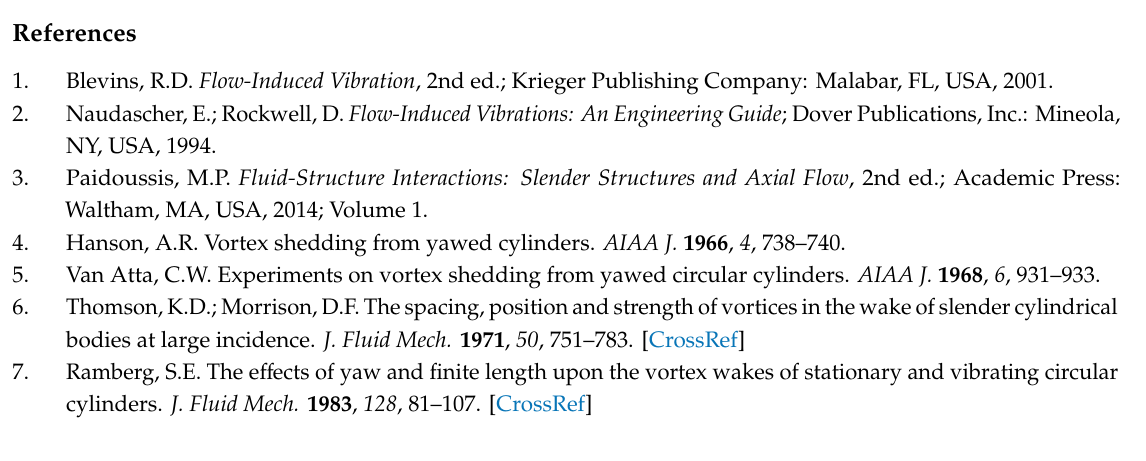
Supplementary Materials: The following are available online at http: // www.mdpi.com / 2311-5521 / 4 / 2 / 100 / s1, The raw data (wind speeds, vortex shedding frequencies, width of vortex shedding peaks in PSDs, inclination angle, axial position) are available online in the file